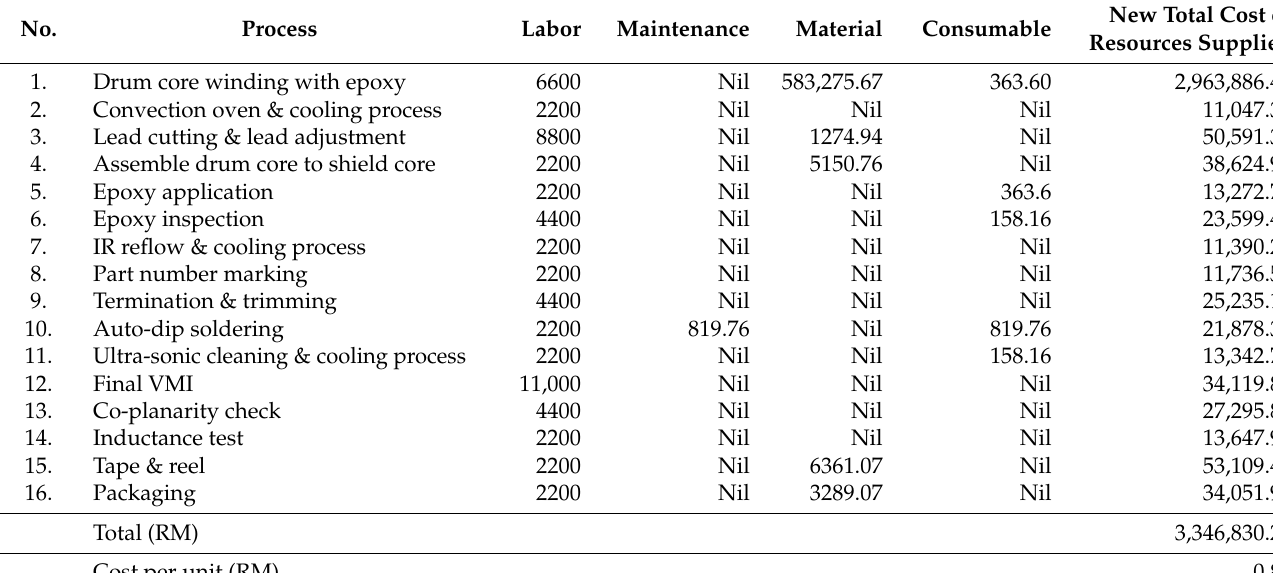
Table 5. Costing structure under integration